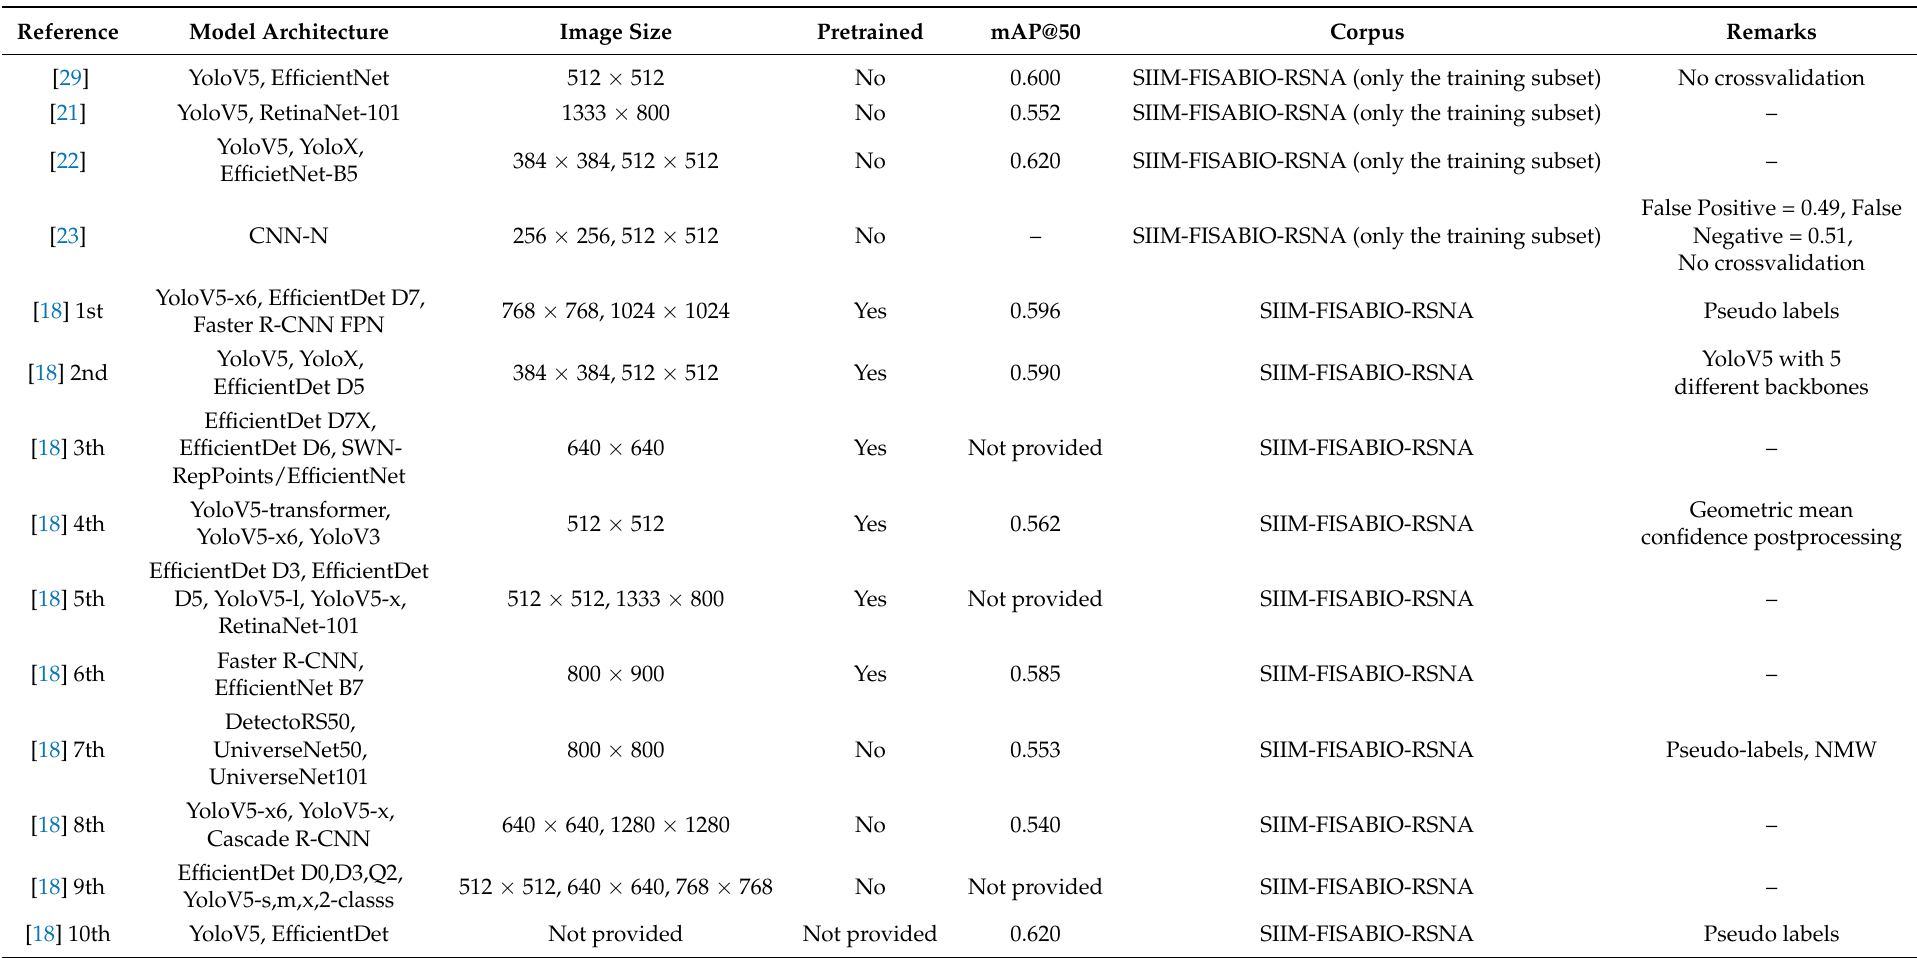
Table 1. Summary of the literature available in the